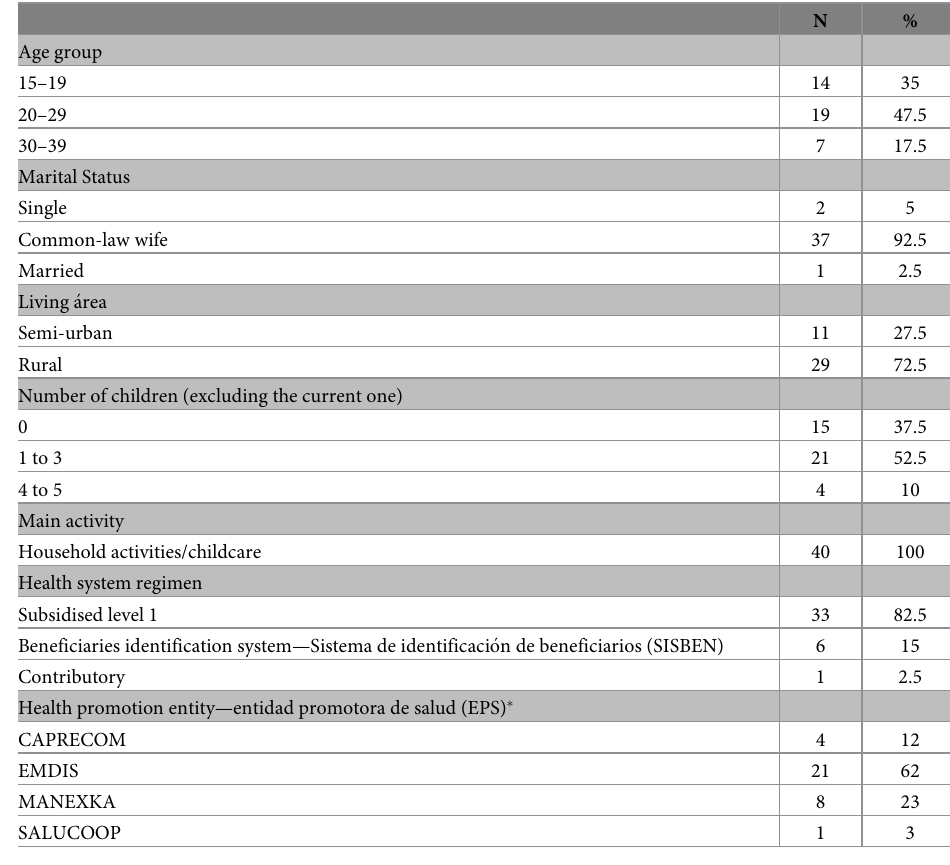
Table 1. Baseline characteristics of study subjects (N =